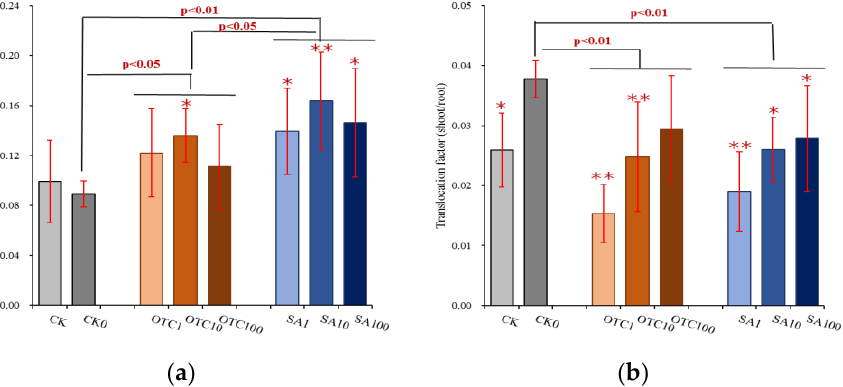
Figure 4. Changes in arsenic translocation in maize cropping system with antibiotics treatments. ( a ) Bioconcentration factor; ( b ) Translocation factor. CK is the soil without manure-based fertilizer; CK0 is the soil with manure-based fertilizer at 0 mg/kg antibiotic concentration; OTC1 is the soil with manure-based fertilizer at 1 mg/kg OTC concentration; OTC10 is the soil with manure-based fertilizer at 10 mg/kg OTC concentration; OTC100 is the soil with manure-based fertilizer at 100 mg/kg OTC concentration; SA1 is the soil with manure-based fertilizer at 1 mg/kg SA concentration; SA10 is the soil with manure-based fertilizer at 10 mg/kg SA concentration; SA100 is the soil with manure-based fertilizer at 100 mg/kg SA concentration. * or ** represents significant differences ( p < 0.05 or p < 0.01) between each antibiotic treatment (e.g., OTC1, OTC10) and CK0; and p < 0.05 or p < 0.01 on the line represents significant differences between treatment groups such as control, OTC, and SA treatments.